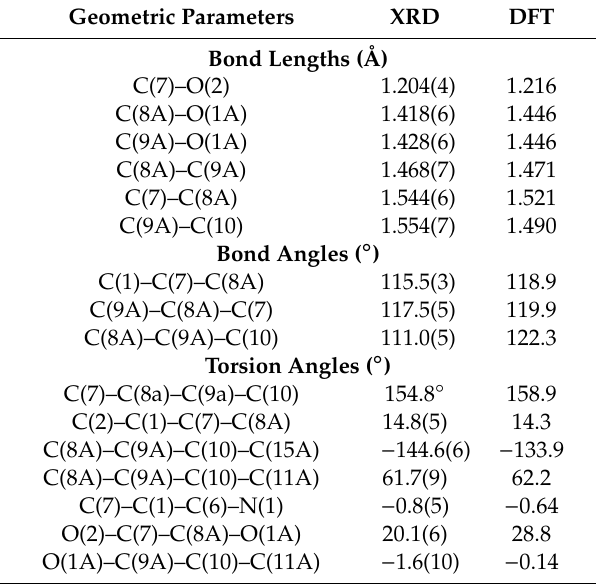
Table 2. Comparison of selected XRD and DFT bond lengths (Å) and angles ( ◦ ) of 2a . Geometric Parameters